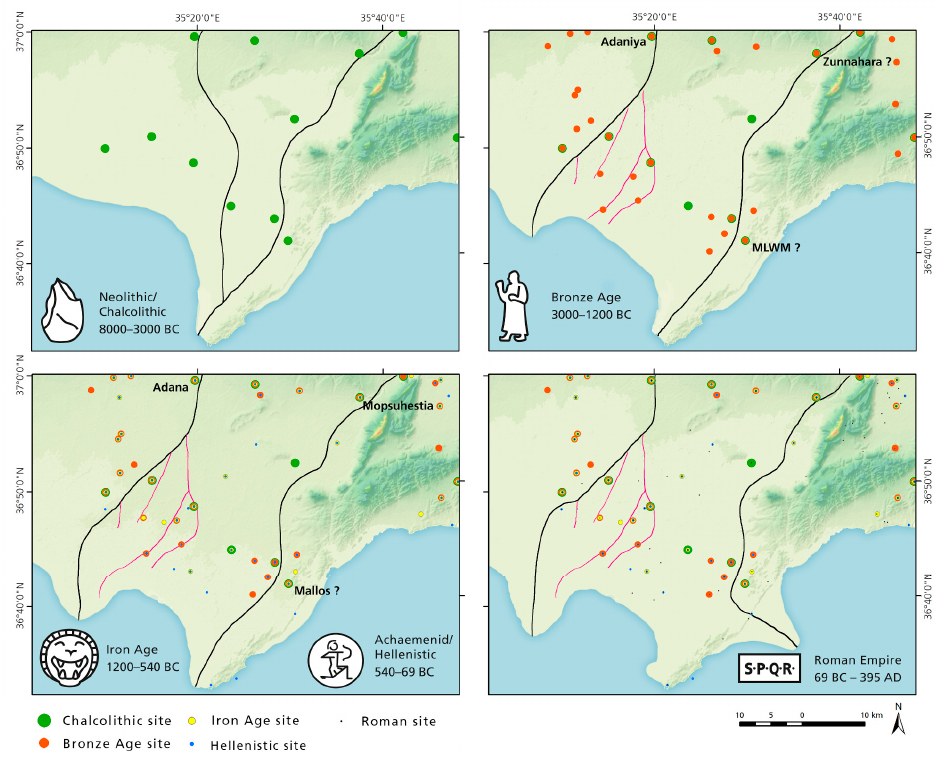
Figure 14. Preliminary reconstruction of the palaeo-landscape of the eastern Çukurova. The schematic black lines represent former river courses of Seyhan and Ceyhan, the pink lines show relict canals, © Susanne Rutishauser.